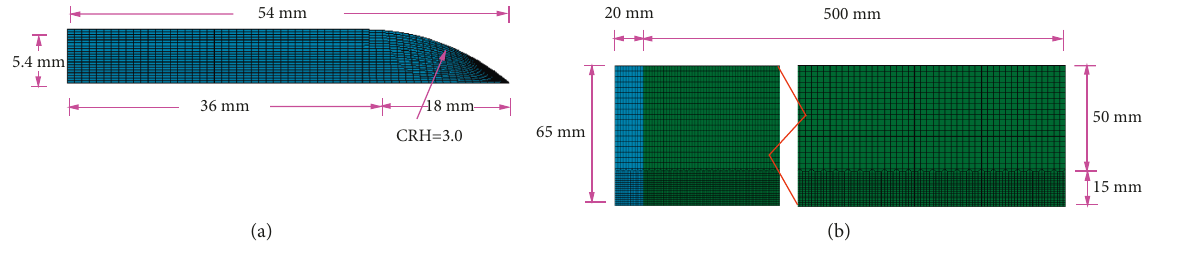
Figure 8: Finite element model. (a) Projectile. (b)